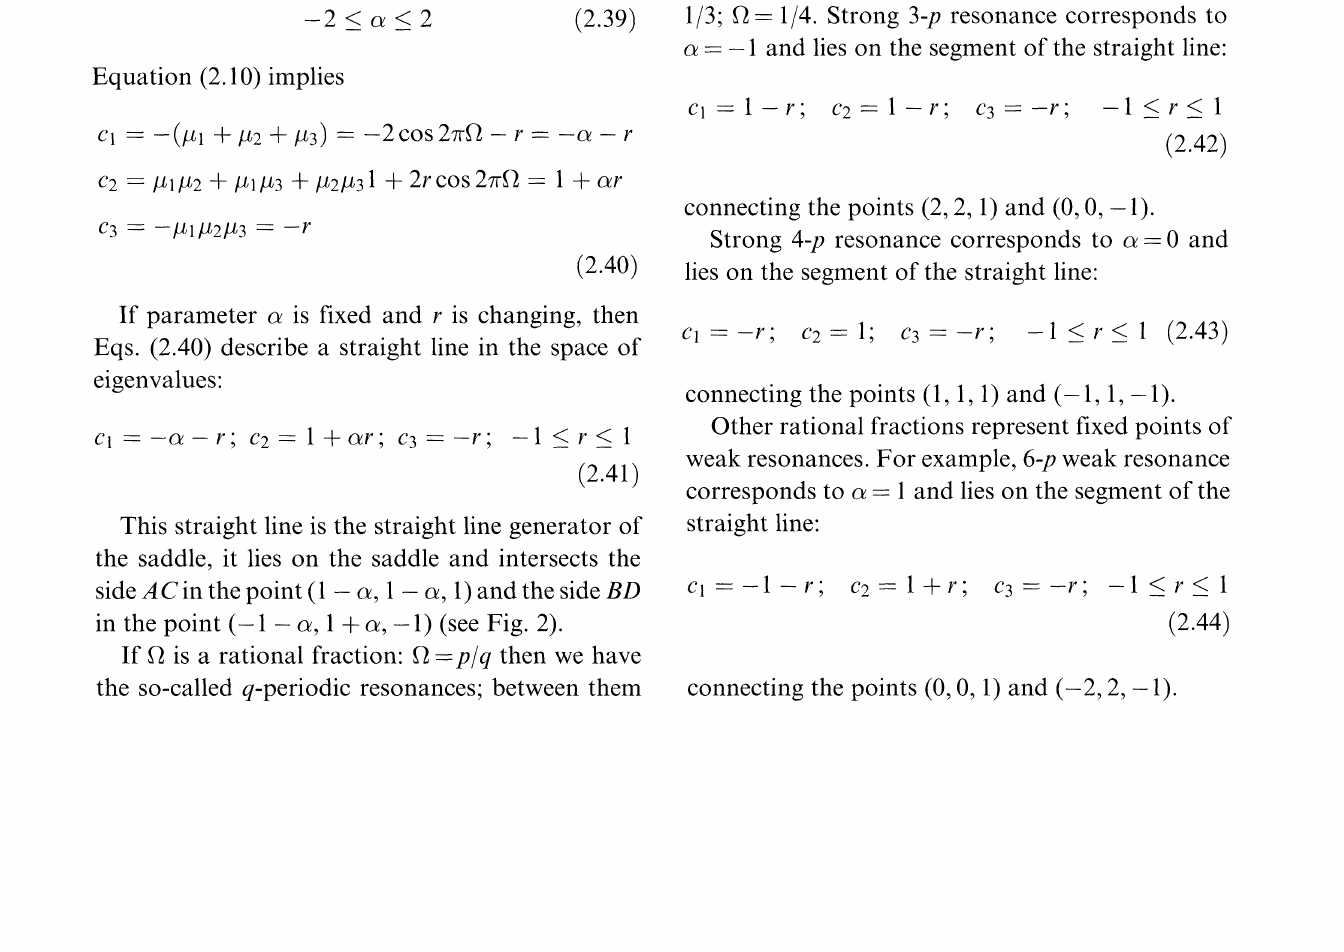
FIGURE 2 The segments of resonances for 3D discrete